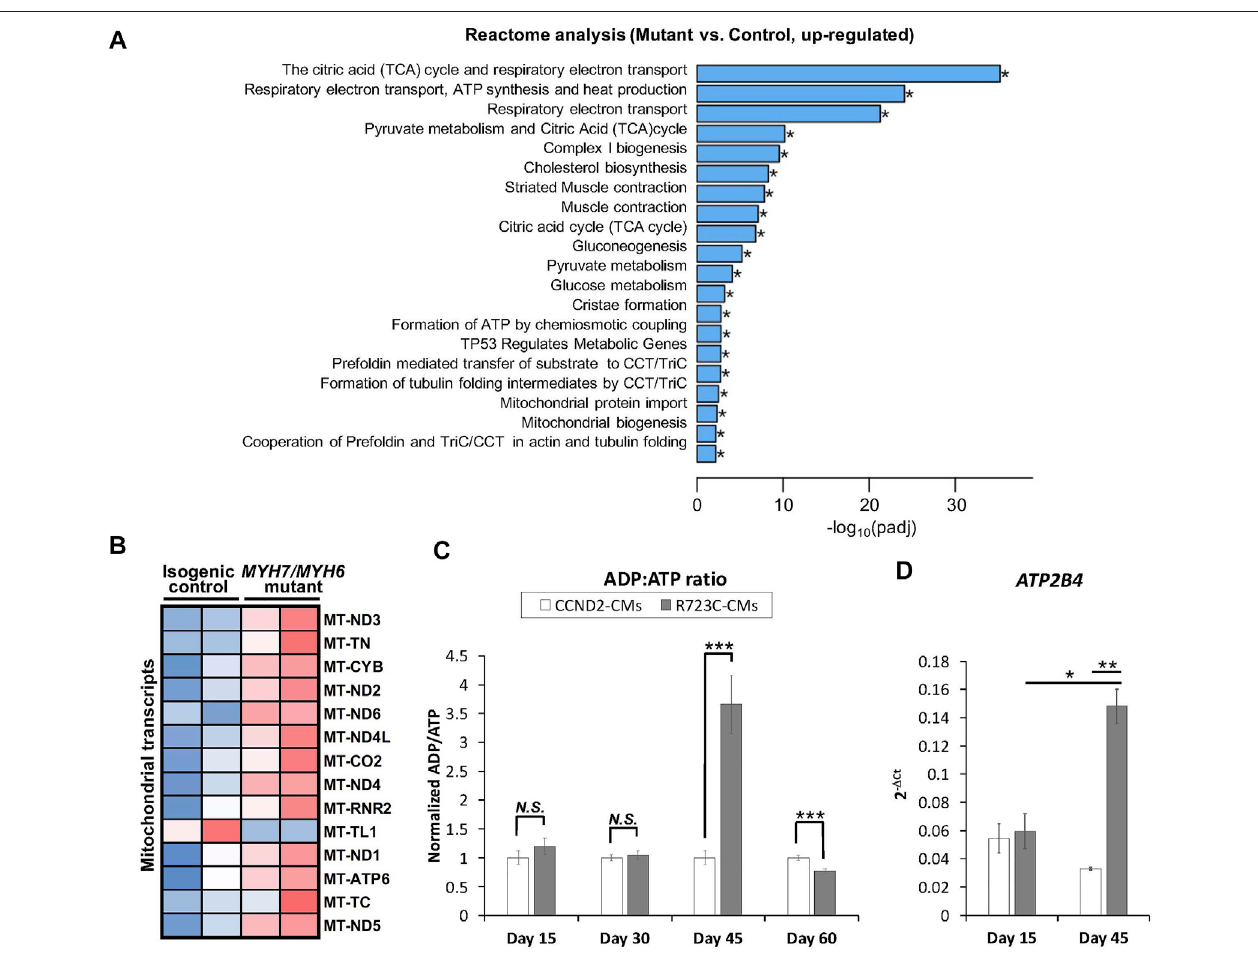
FIGURE 5 | MYH7/MYH6 mutation results in dysregulation of the metabolic pathways and ADP/ATP dynamics. (A) Bar graph showing top 20 signi fi cantly altered metabolic pathways in the mutant cardiomyocytes relative to control cardiomyocytes; * p < 0.05. (B) Heatmap of the DEGs mitochondrial transcripts in the mutant cardiomyocytes relative to control cardiomyocytes. (C) ADP:ATP ratio using the lysate from control and mutant cardiomyocytes. Notice the sharp peak at Day 45 of differentiation inthemutant cellsrelative tocontrolcells.Datarepresents mean±SEM;*** p < 0.005; N.S. :notsigni fi cant;Student t test; n =3wellsofdifferentiated cardiomyocytes for each condition. (D) qPCR analysis for ATP2B4 transcripts using the RNA isolated from control and mutant cardiomyocytes at Day 15 and Day 45 of differentiation. Data represents mean ± SEM; * p < 0.05; ** p < 0.01; Student t test; n = 9 cell lysate samples for Day 15 conditions, n = 7 cell lysate samples for Day 30 conditions, n = 10 cell lysate samples for Day 45 conditions, n = 6 cell lysate samples for Day 60 conditions.